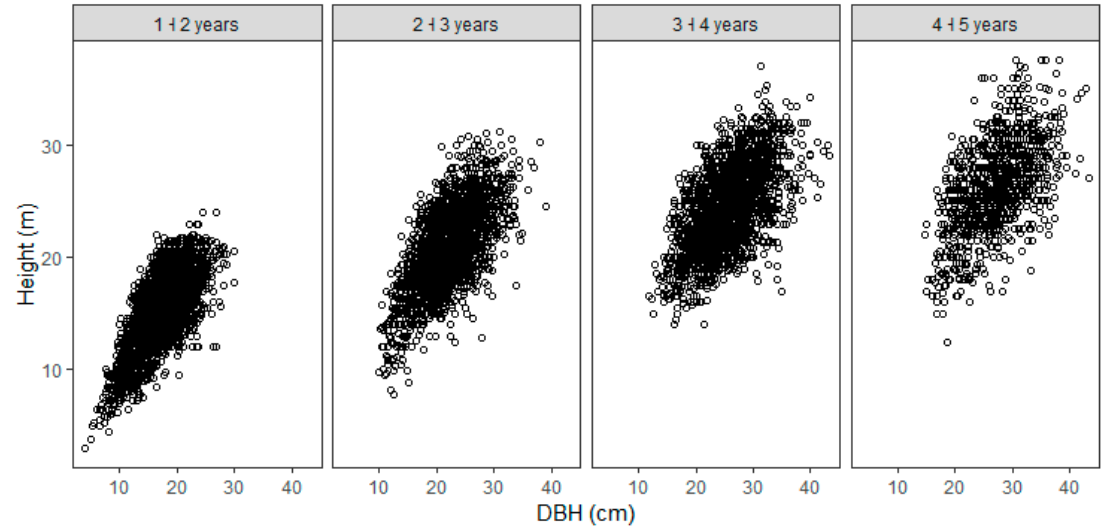
Figure 2. Dispersion of paired DBH and h data by age classes used to fit models to represent the height–diameter relationship (Approach 1).